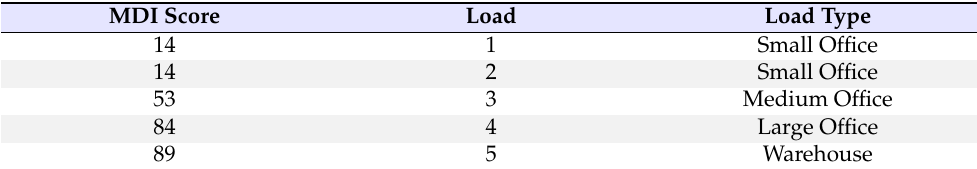
Table 2. MDI Scores for Individual Loads. Information from USCG Office of Civil Engineering, and NASA are used to calculate the case study MDI scores. In the case study, all MDI scores are represented on a 0-100 scale and all loads shown are considered critical.